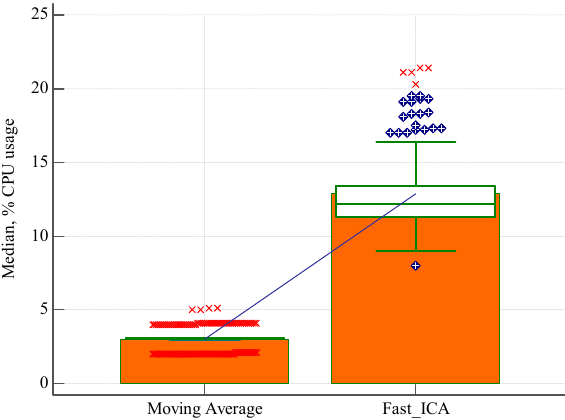
Table 3. Concordance correlation coefficients.